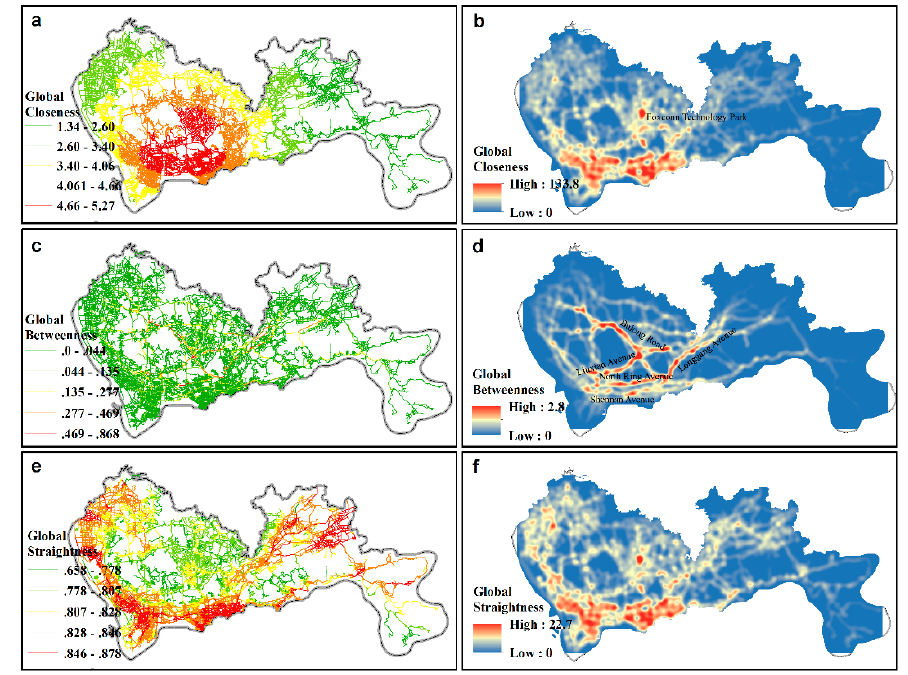
Figure 5. Spatial distributions of global centrality indicators of street networks in Shenzhen. The centrality indicators of each edge are averaged from two nodes linking to this edge, and they are divided into five levels using natural breaks in ArcGIS10.2 ( a , c , e ); kernel density estimation of centrality indicators at nodes ( b , d , f ).